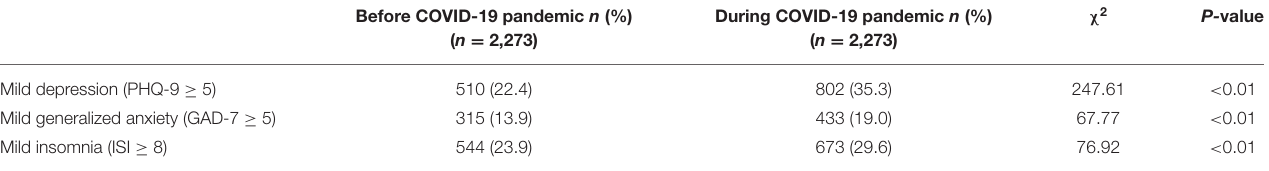
TABLE 2 | Differences of the occurrence of mild forms of depression, generalized anxiety and insomnia during the COVID-19 pandemic and before the outbreak. Before COVID-19 pandemic n (%) ( n = 2,273)